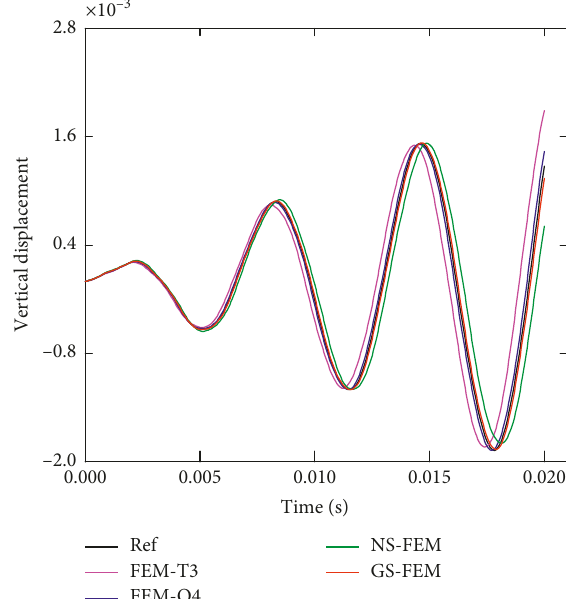
Figure 35: Transient response of point A.